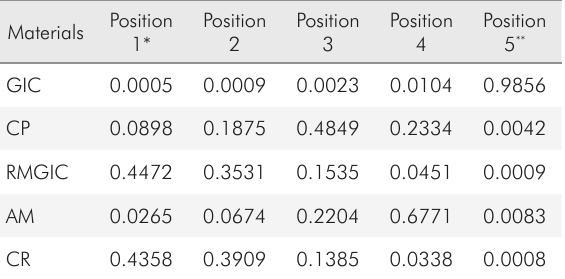
Table 4. Ranking of materials according to probability of failure.